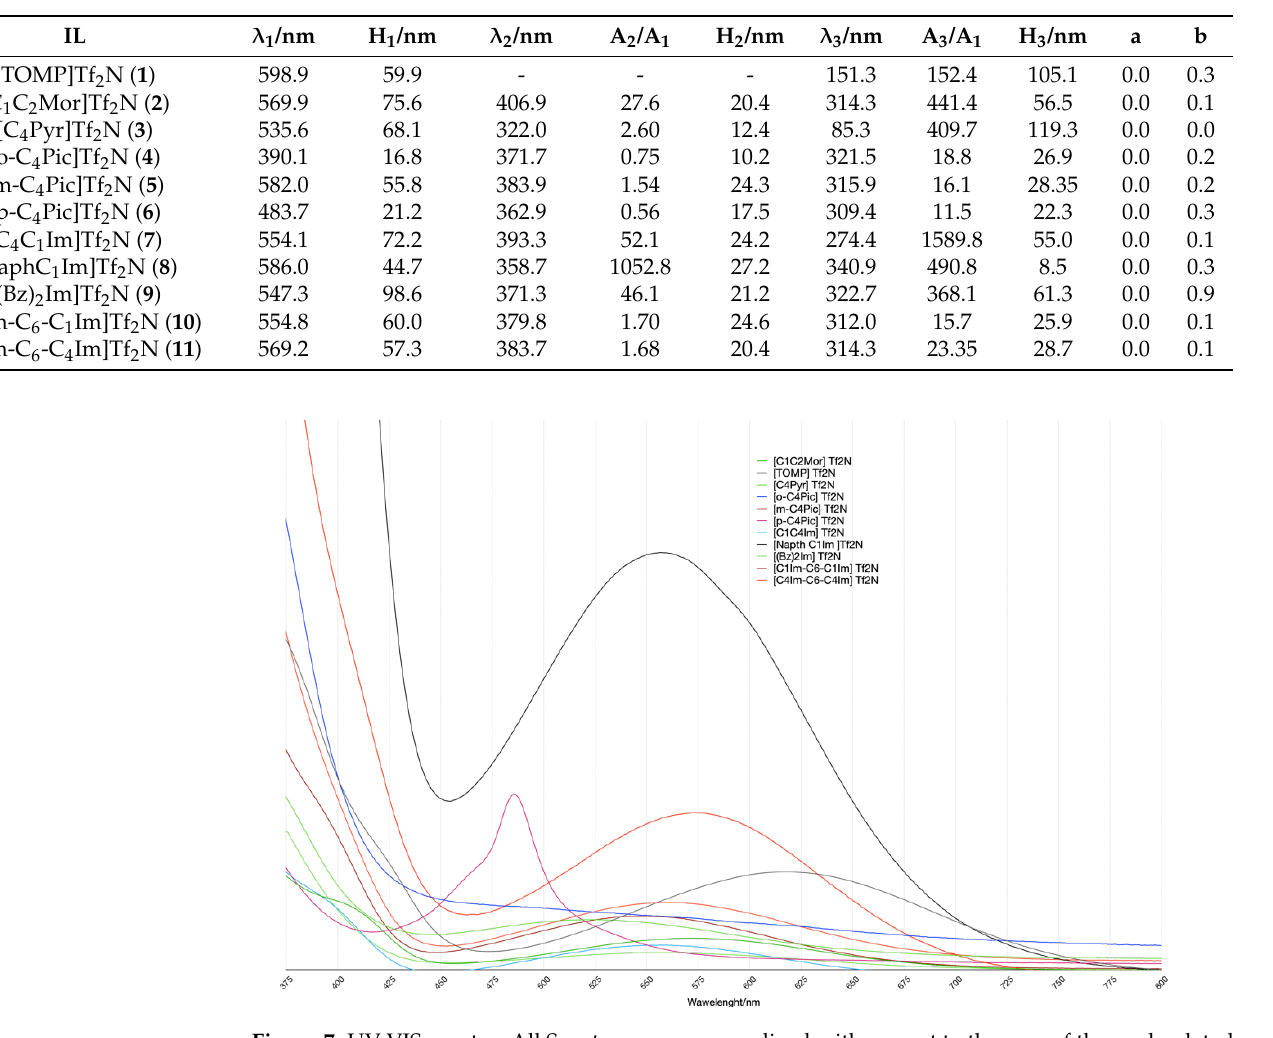
Figure 7. UV-VIS spectra. All Spectra were renormalized with respect to the area of the peak related to the π ⟶ π * transition (its maximum is at λ 1 wavelength of Table 3). This was for a better comparison of the several systems studied. Thus, the vertical axis corresponds to arbitrary units. Table 3. Deconvolution fitting of UV-VIS spectra. H is the half-width at half-height. The areas A were normalized with respect to the area of transition 1.